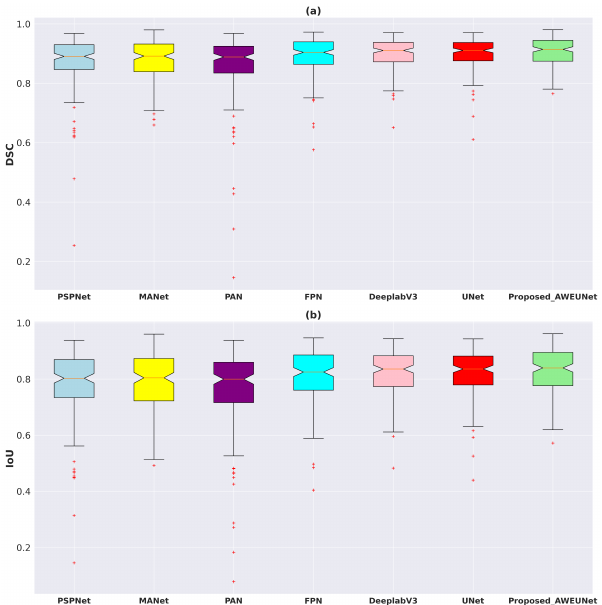
Figure 9. Boxplots of ( a ) Dice coefficient (DSC) and ( b ) intersection over union (IoU) scores for all test samples of the LIDC-IDRI lung nodule segmentation dataset. Different boxes indicate the score ranges of several methods; the red line inside each box represents the median value, and all values outside the whiskers are considered outliers, which are marked with the (+) symbol.